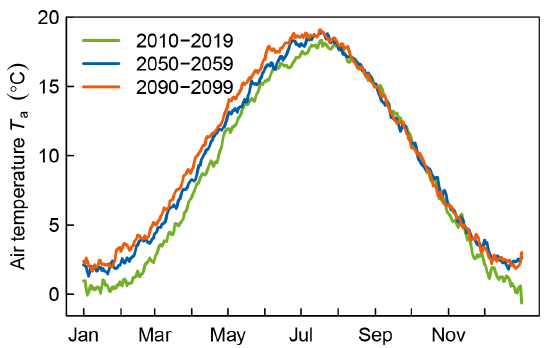
Figure 6. Projected changes in over-lake near-surface air temper- ature under RCP4.5. Lines show decadal means over all climate projections and all four